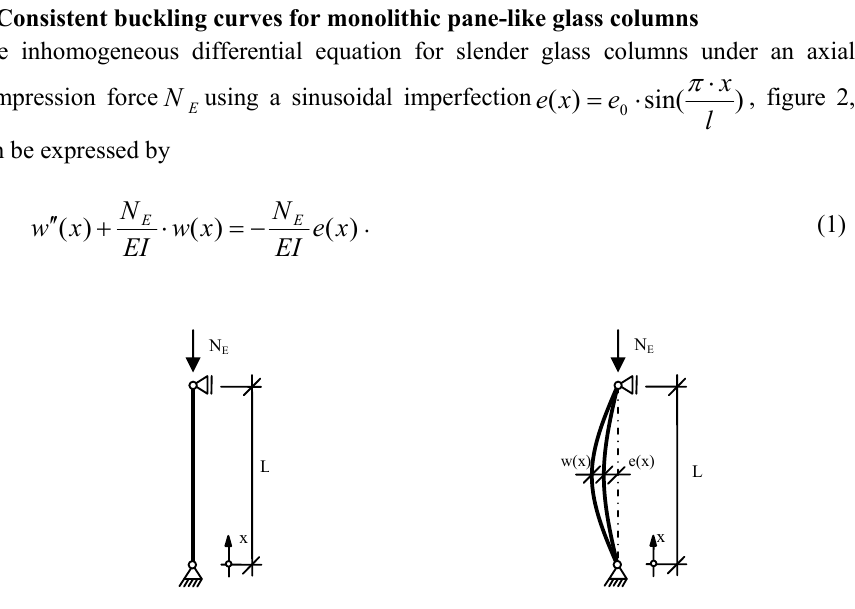
Figure 2: Origin, perfect and deformed imperfect system of a slim column, e(x)=imperfection, w(x)= bending ordinate. Assuming that bending and imperfection shape are affine, the total deflection in the l middle of the column ) 2( xw = results from both the initial imperfection ges flexural bending deflection w due to the normal force and